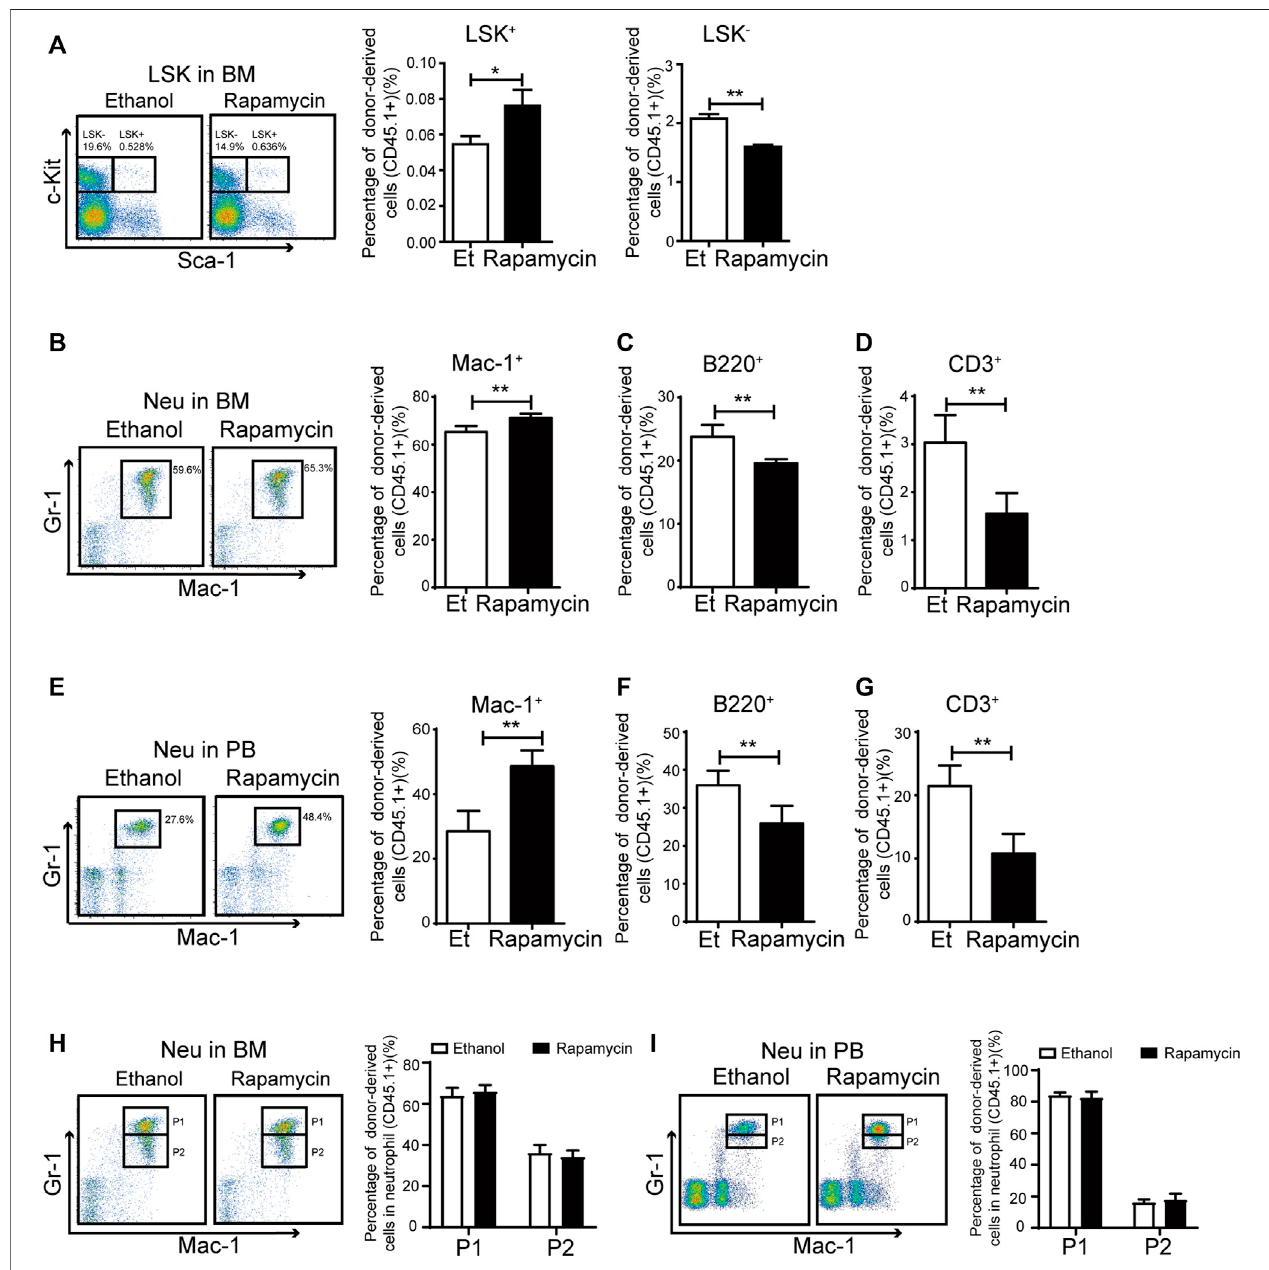
FIGURE3| Oraladministrationofrapamycinenhancedmyeloidcellsproliferationupontransplantation (A) Percentageofdonor-derivedLKS + (CD45.1)anddonor- derived LKS – (CD45.1) cells in BM of mice (CD45.2) treated by rapamycin or ethanol for 4 months, n = 3 (B – D) Percentage of donor-derived myeloid cells (CD45.1), donor-derivedBcells(CD45.1)anddonor-derivedTcells(CD45.1)inBMoftwogroups,n=3 (E – G) Percentageofdonor-derivedmyeloidcells(CD45.1),donor-derived B cells (CD45.1) and donor-derived T cells (CD45.1) in PB cells of two groups, n = 3 (H – I) FACS analysis of donor-derived neutrophils (CD45.1) in BM and PB of mice treated with rapamycin or ethanol for 4 mouths, n =